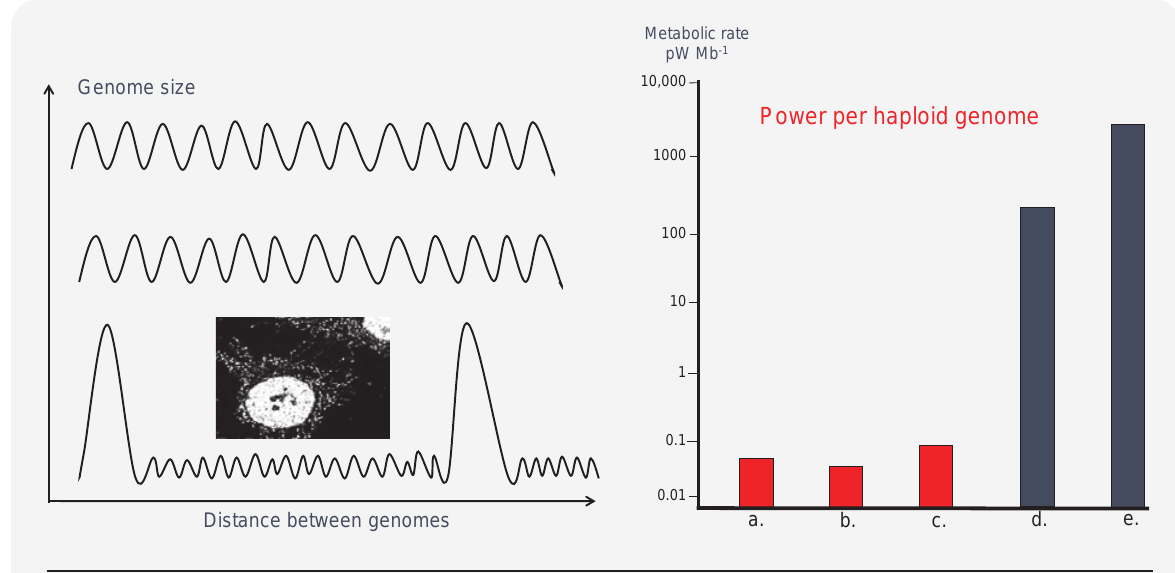
Figure 10. The cost of extreme polyploidy in comparison with mitochondrial genomes. Bacteria have a genomic symmetry (right panel) in which each genome controls a similar volume of cytoplasm in both small bacteria (E. coli, top) or giant bacteria (Epulopiscium, middle). In contrast, eukaryotes have a genomic asymmetry in which tiny mitochondrial genomes (inset, bottom) support, energetically, a massive nuclear genome. Taking into account these differences shows that eukaryotes have orders of magnitude more energy availability per haploid copy of each gene (right panel). Data from Lane and Martin (2010), based on measured metabolic rate and known genome sizes and ploidy. Bacteria shown in red, eukaryotes in blue; note the log scale on the Y axis. (a) E. coli; (b) Thiomargarita; (c) Epulopiscium; (d) Euglena; (e) Amoeba